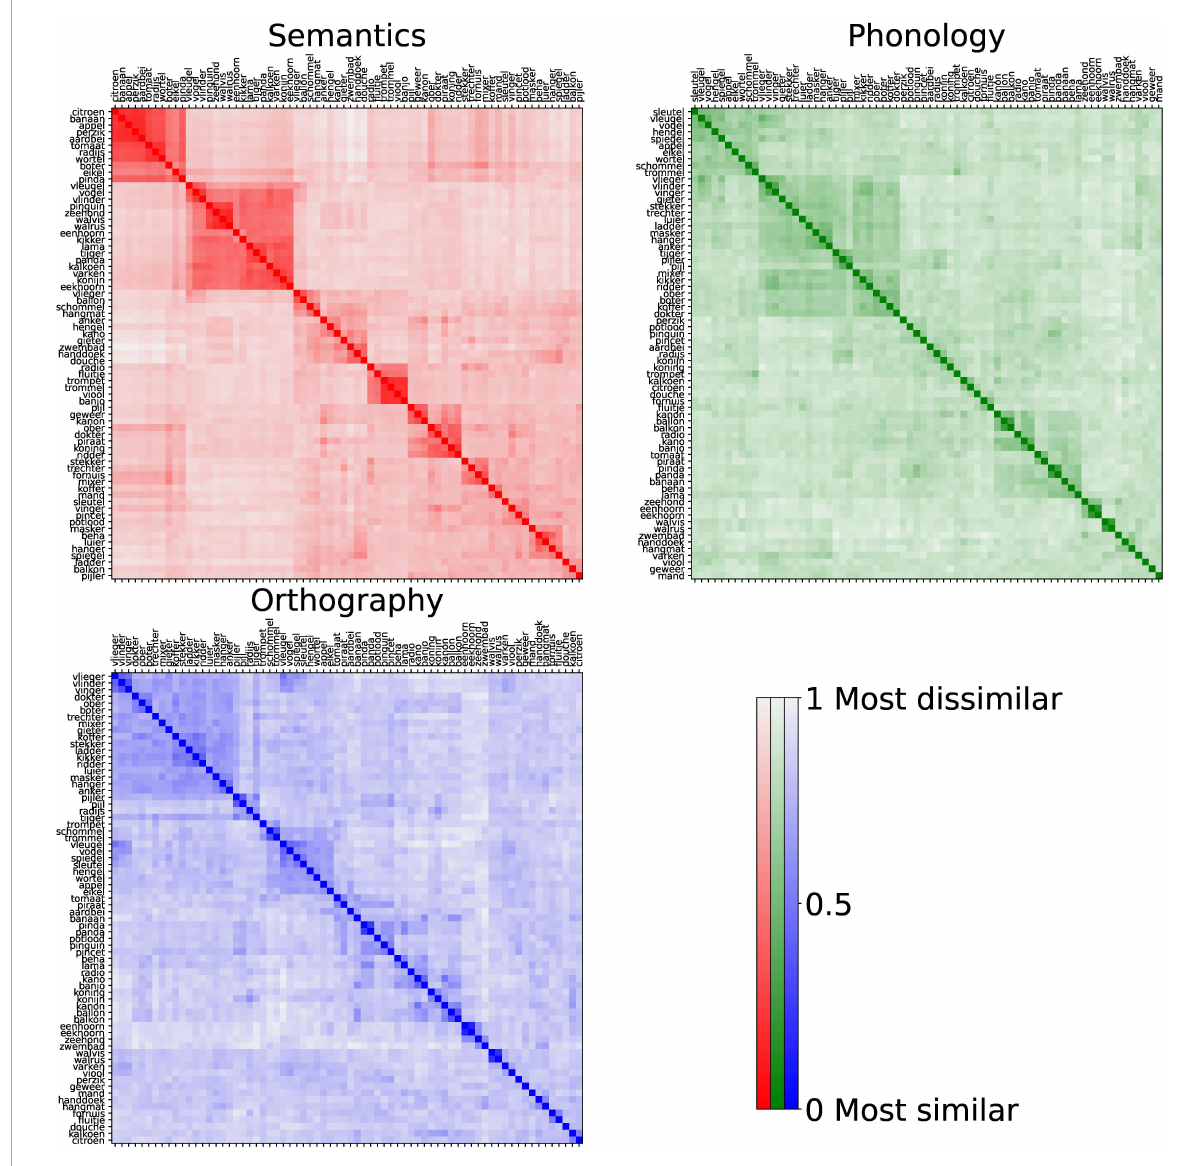
FIGURE4 The group-level RDMs for each modality. Color indicates the degree of similarity (more saturated means more similar). The rows and columns have the same order and are sorted by hierarchical clustering, causing similar items to be adjacent, revealing the similarity clusters (saturated squares in the